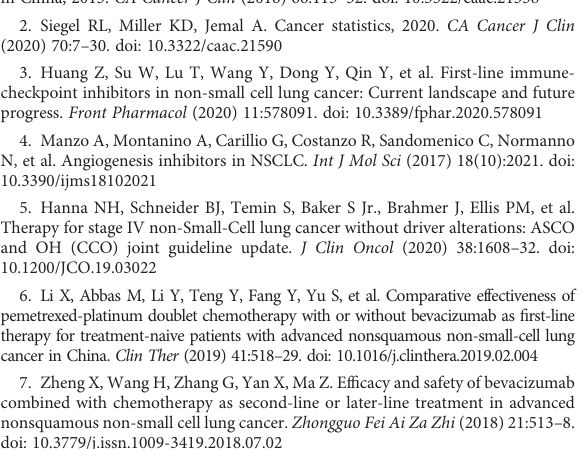
SUPPLEMENTARY FIGURE 1 Flow diagram of the study design. BEV: bevacizumab. ICIs: immune checkpoint inhibitors